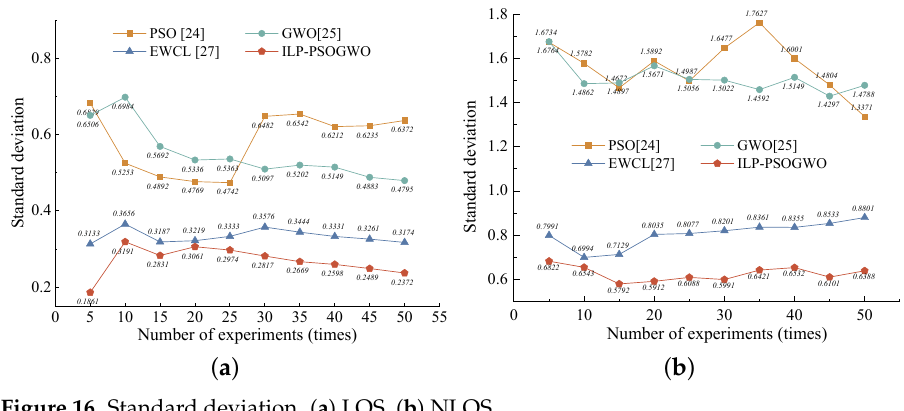
Figure 16. Standard deviation. ( a ) LOS. ( b ) NLOS. (ii) Cumulative probability distribution